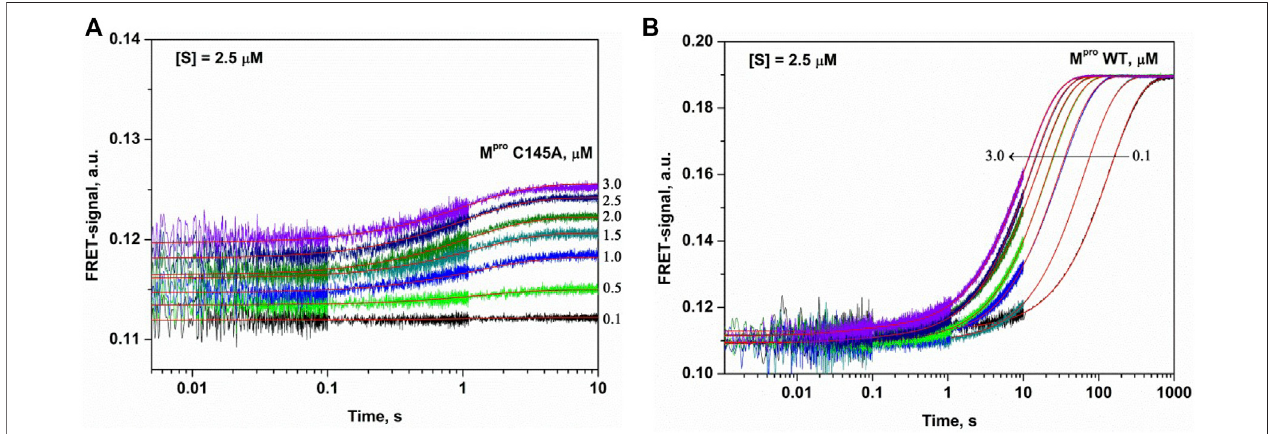
FIGURE 3 | Experimental and theoretical (smooth curves) kinetic curves for the FRET signal changes during the interaction of C145A M pro (A) or WT M pro (B) with FRET-S. The FRET-S concentration was 2.5 µM, and the enzyme concentration is indicated in the panel.